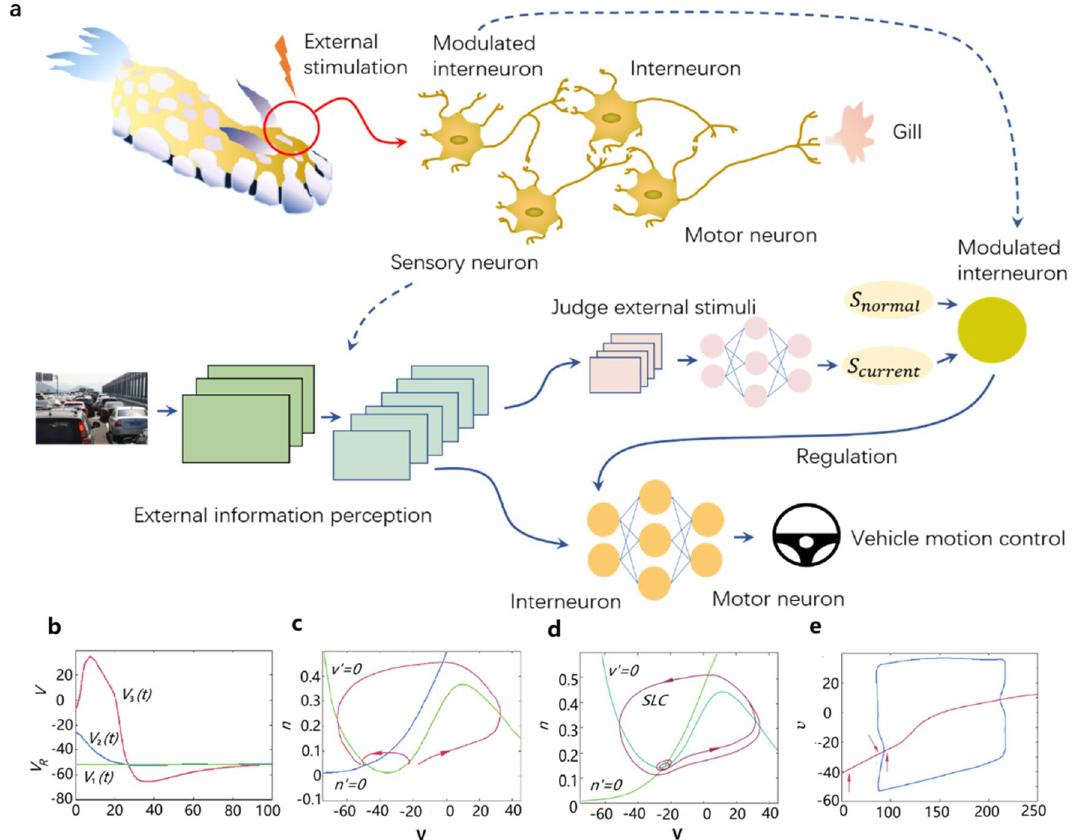
Figure 2. Sensitive non-associative learning neural network model. ( a ) Comparison of the nerve circuit of gill constriction reflex of Aplysia with the model in this paper. In the model, the convolution part is equivalent to the sensory neuron of the Aplysia; the modulation interneuron establishes the model alone, and the full connection layer of the lower half branch is equivalent to the interneuron, and the last layer is equivalent to the motor neuron. ( b ) Solution of Morris–Lecar equation, including the nerve potential curve when the external stimulus is insufficient to produce nerve excitation and the nerve potential curve when generating nerve excitation. ( c ) There is only one stable fixed point in the (V, n) phase plane. From the initial state, V and N will eventually return to the resting state. ( d ) There is a limit cycle in the phase plane. When the state converges to the limit cycle, it will oscillate and cannot return to the resting state. ( e ) Bifurcation diagram of ML model under Hopf bifurcation parameter. Voltage is a function of current. The curves above and below the fixed-point curve correspond to the maximum and minimum voltages along the periodic track respectively. The solid line represents the stable solution and the dotted line represents the unstable solution. For a more detailed explanation of figure b, c, d and e, please refer to 30